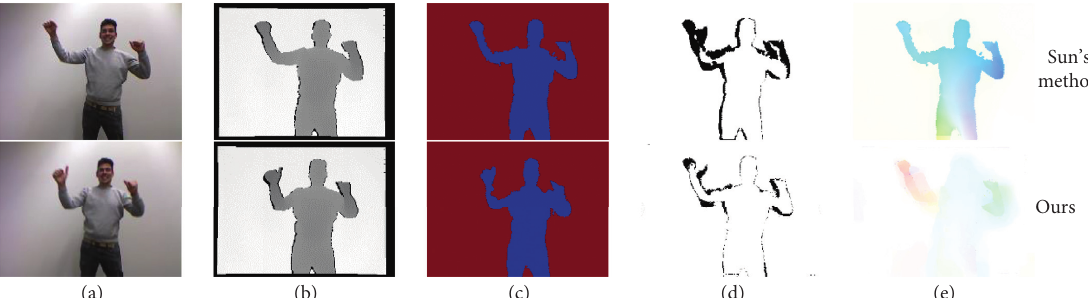
Figure 8: Pose 3 in “Alex” sequence. Input two consecutive frames about Pose 3 in “Alex” sequence. (a) RGB images. (b) Depth images. (c) Segmentation K � 2. (d) Occlusions. (e) Motion.